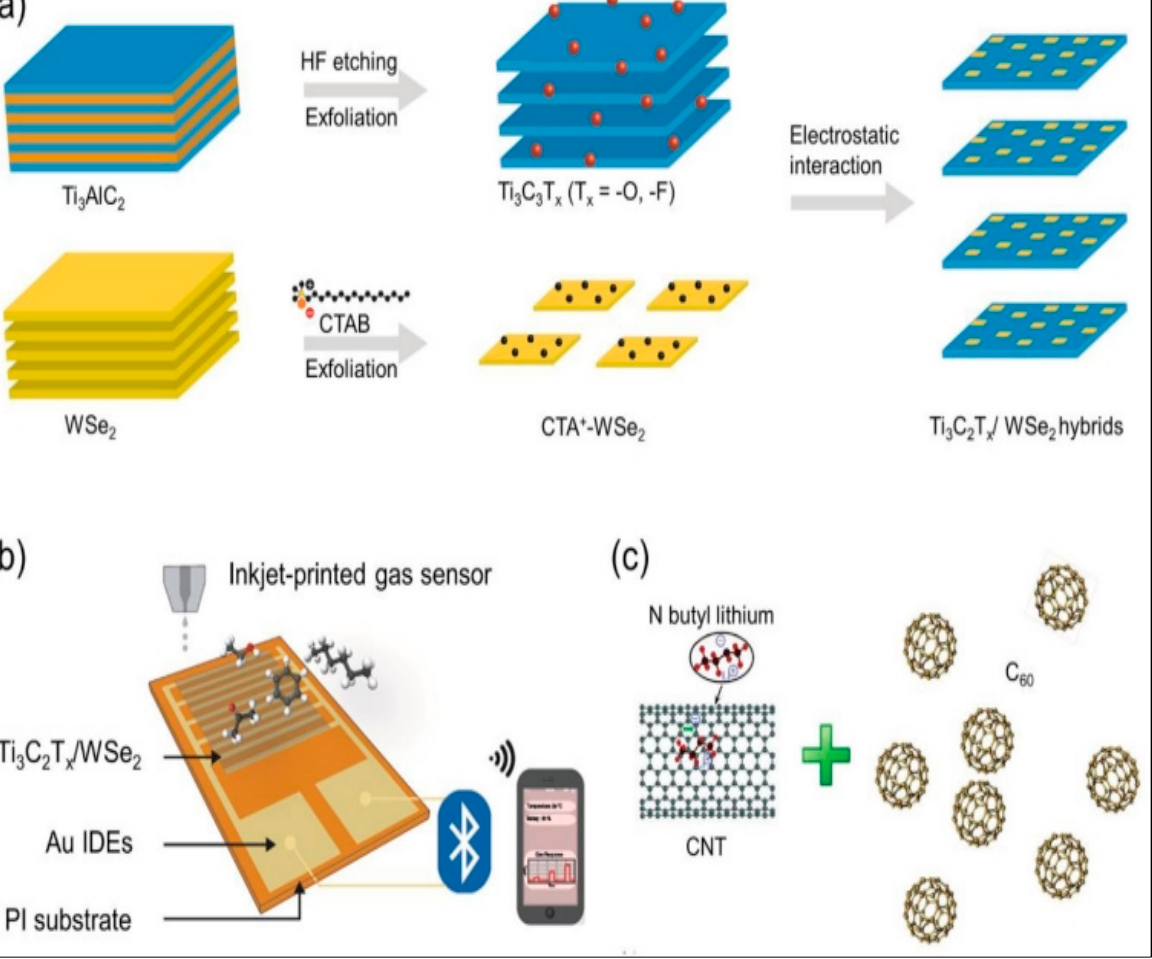
Figure 13. ( a ) Schematic representation of the Ti 3 C 2 Tx/WSe 2 nanohybrids fabrication. ( b ) schematic illustration of the Ti 3 C 2 Tx/WSe 2 sensor printed inkjet and the wireless monitoring system for VOC gas detection, (Reprinted from [173] Copyright 2020, Springer Nature, Open Access) ( c ) Representation of two types of carbon nano-fillers of CNT and fullerenes. (Reprinted [174] Copyright 2016, The Royal Society of Chemistry).